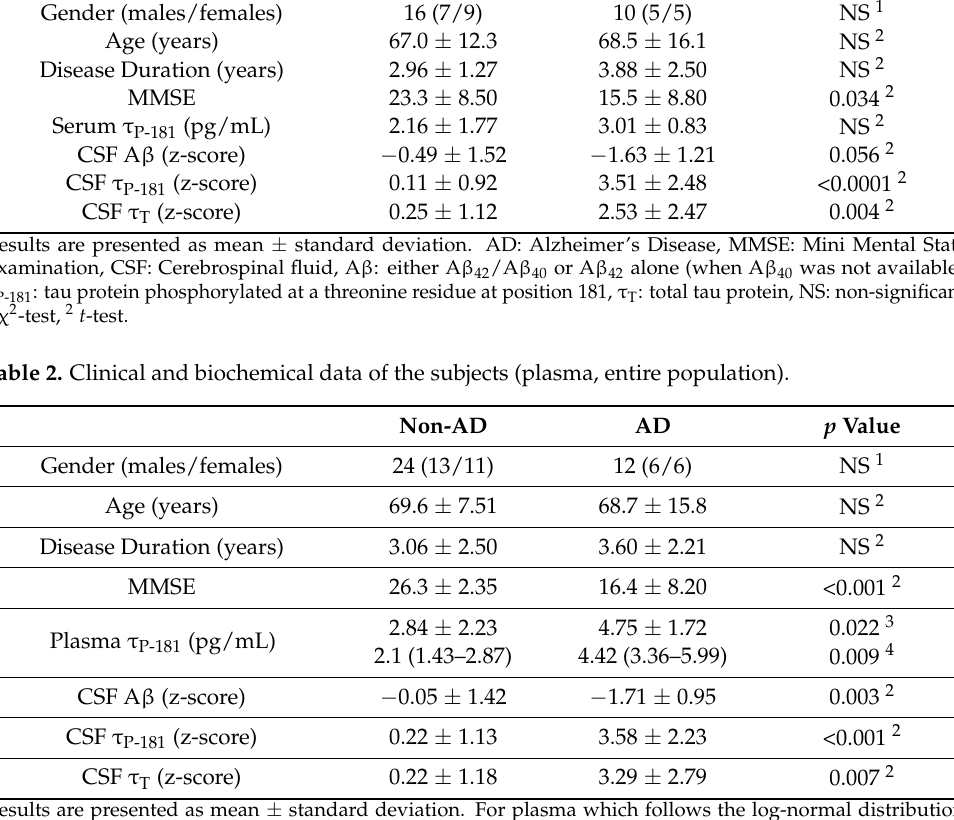
Table 1. Clinical and biochemical data of the subjects (serum subpopulation). Non-AD AD p Value Gender (males/females)